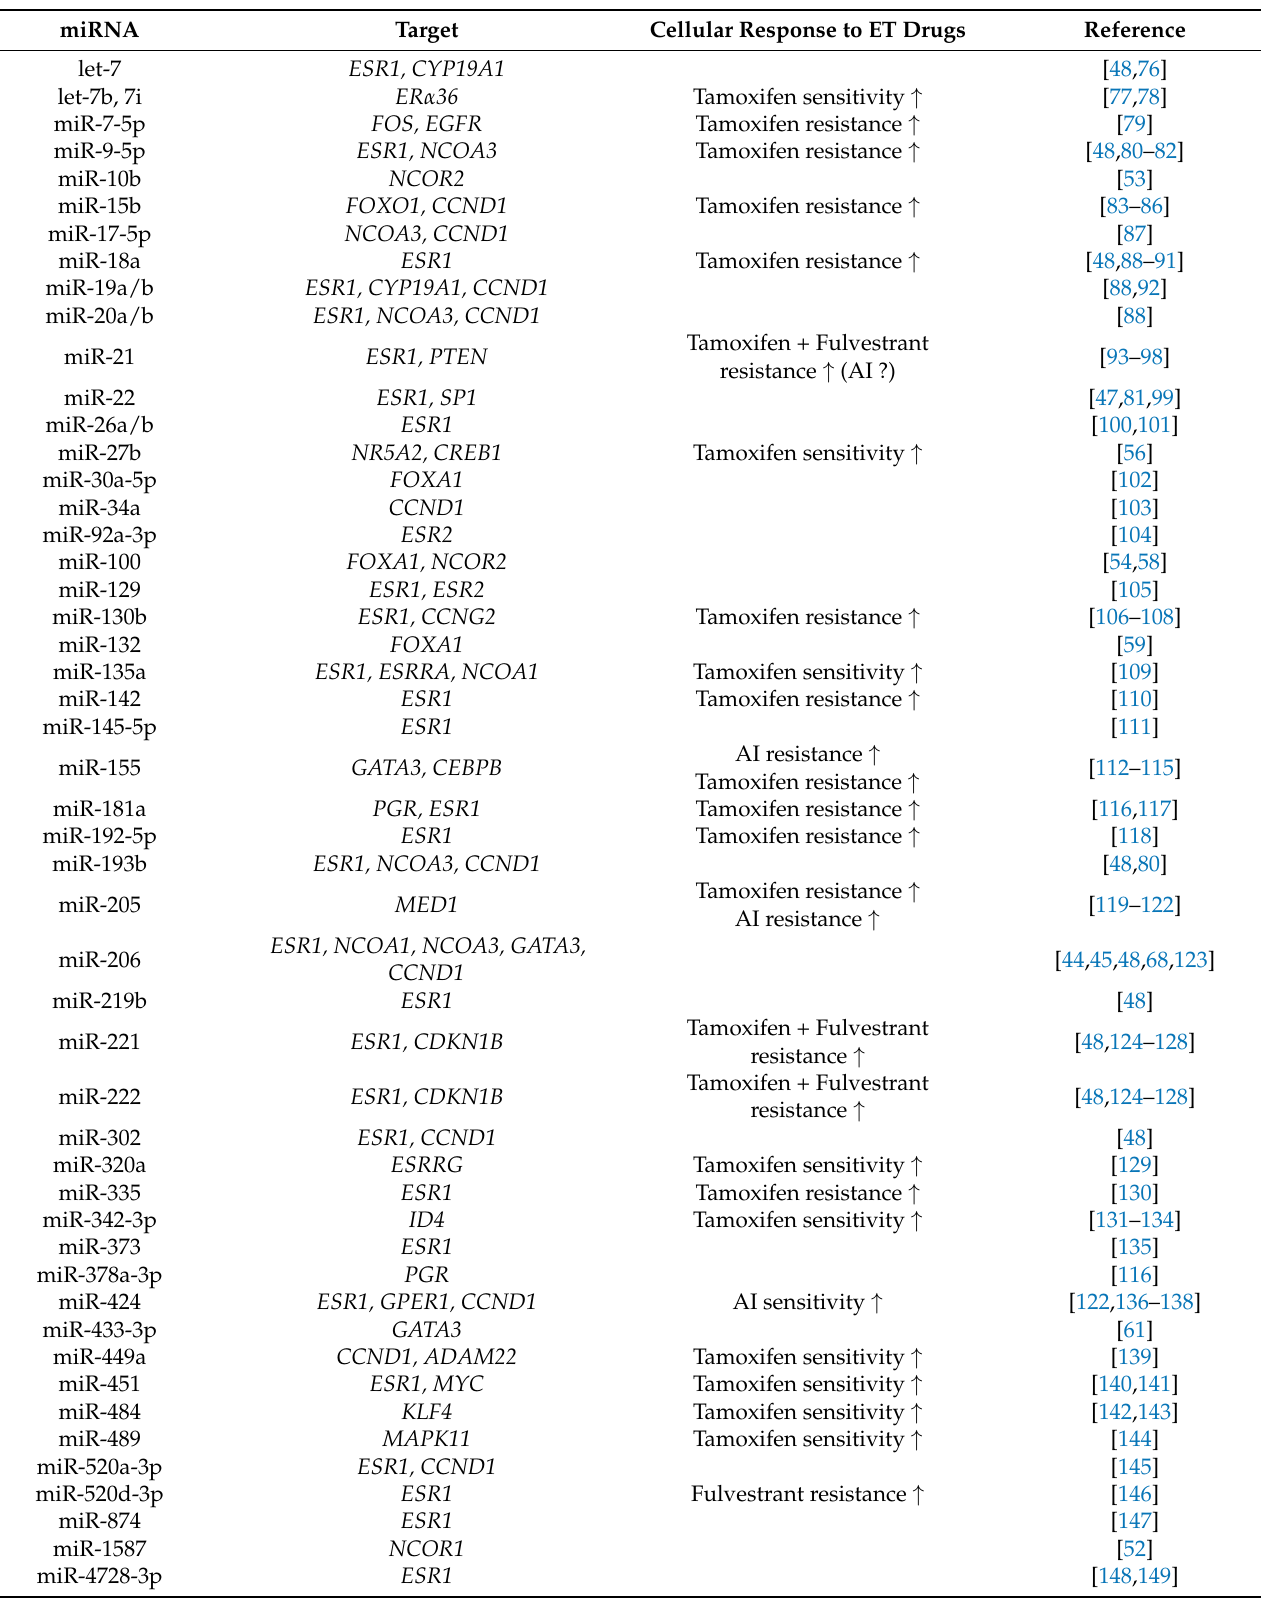
Table 1. MiRNAs directly targeting the mRNA of ESR1, or other genes involved in estrogen signaling or the estrogen response, and their in vitro effect on sensitivity of BC cells to ET drugs. To date, not every miRNA–mRNA interaction shown here has been examined with regard to ET drug